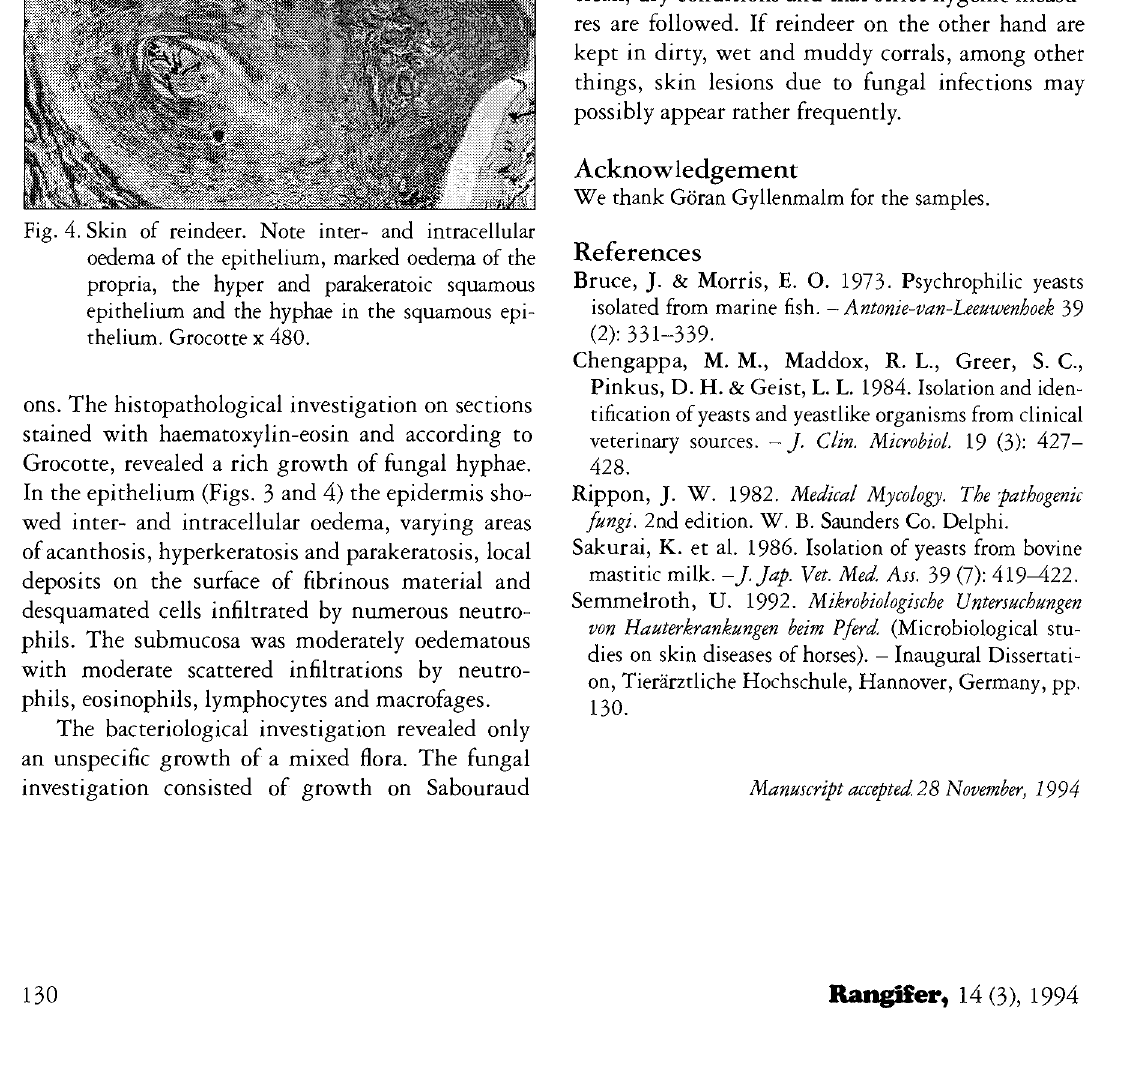
Fig. 3. Skin of reindeer. Note the oedema of the propria and the rich amount of hyphae in the hyperkeratotic squ amous epithelium of the surface and hair follicle.